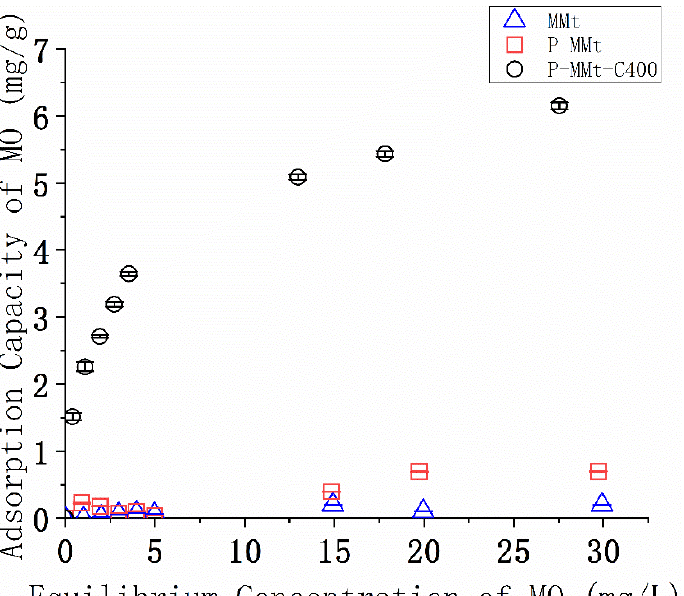
Figure 9. MO adsorption by MMt, P-MMt, and P-MMt-C400 in different equilibrium concentrations of MO; SD is added to each point as an error bar, n =